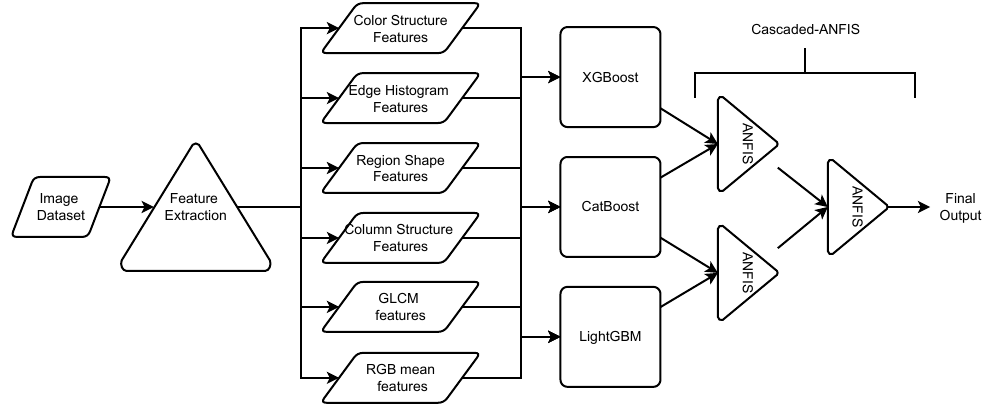
Figure 5. Construction of the novel proposed